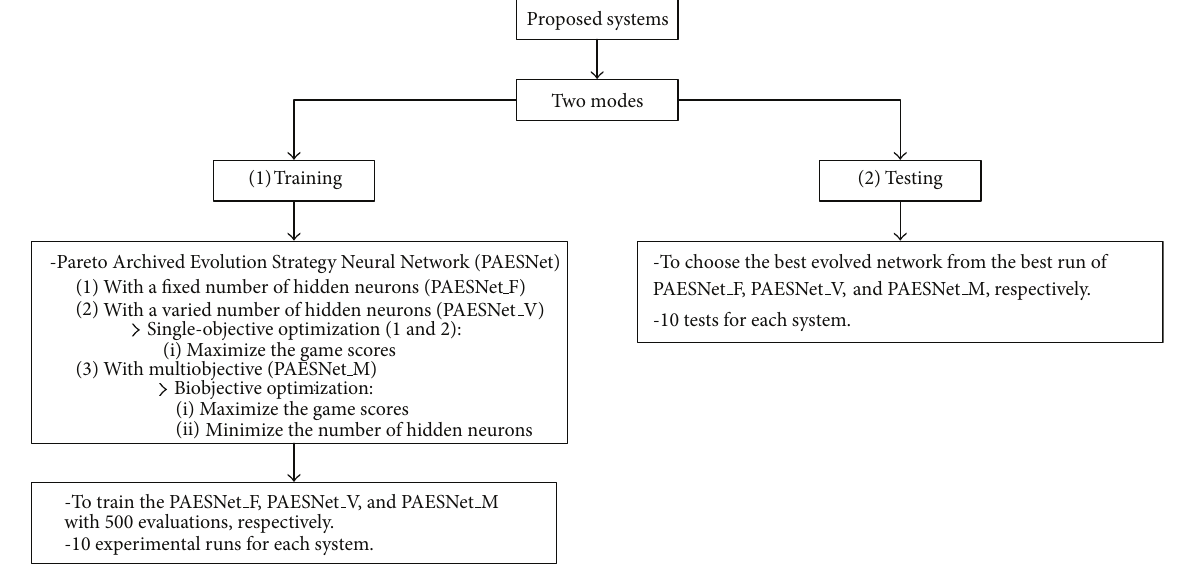
Figure 1: The overview of the